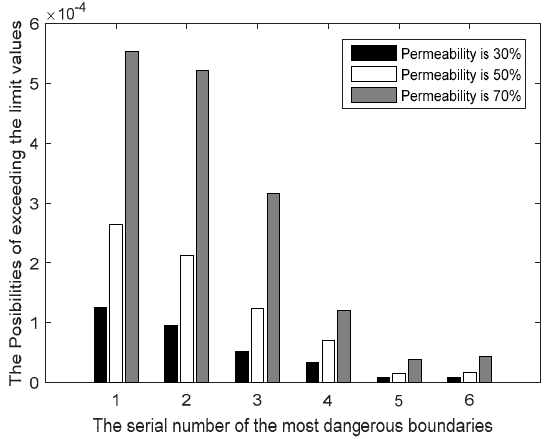
Figure 7. Comparison of operation margin before and after adjustment.